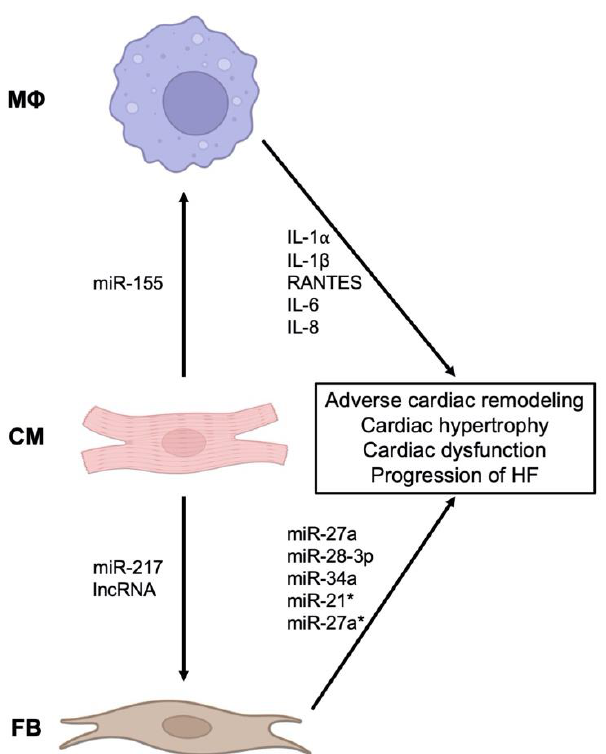
Figure 4. The role of EVs and inflammation in heart failure. Interaction between cardiomyocytes (CM), macrophages (M φ ), and fibroblasts (FB) through EVs in the pathogenesis of heart failure. Because inflammation and adverse cardiac remodeling are interrelated [72], the role of fibroblast-derived EVs is equally important. In vitro, fibroblasts stimulated with TNF- α release EVs containing miR-27a, miR-28-3p, and miR-34a, which dysregulate the nuclear factor erythroid 2–related factor 2 (Nrf2) pathway that ordinarily prevents oxidative injury and protects against adverse cardiac remodeling and dysfunction (Figure 4) [73].